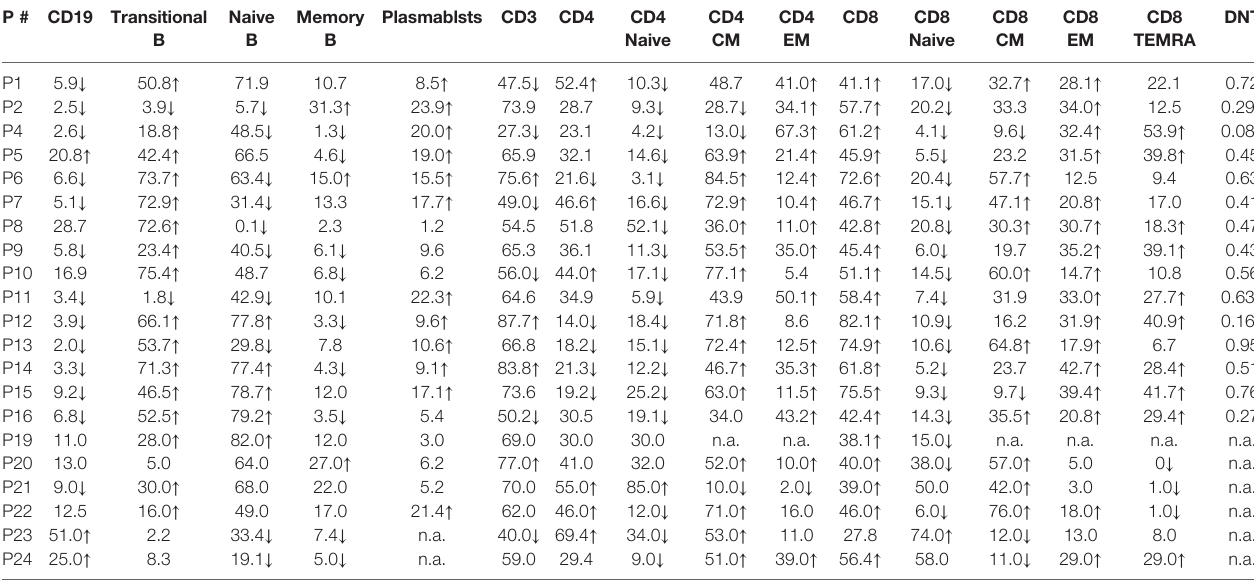
TABLE 2 | Lymphocyte subpopulations in APDS patients.